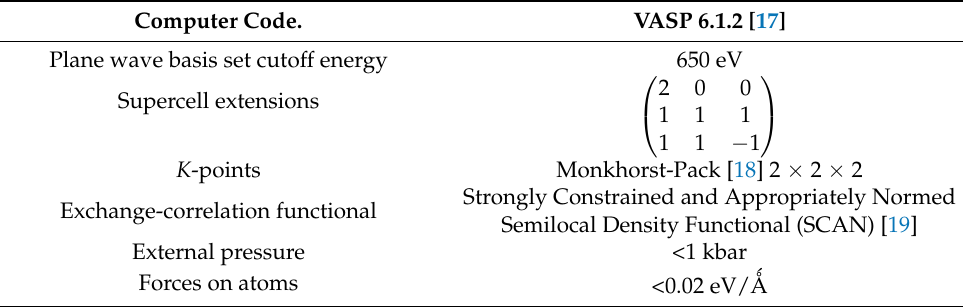
Table 1. Main calculation parameters.